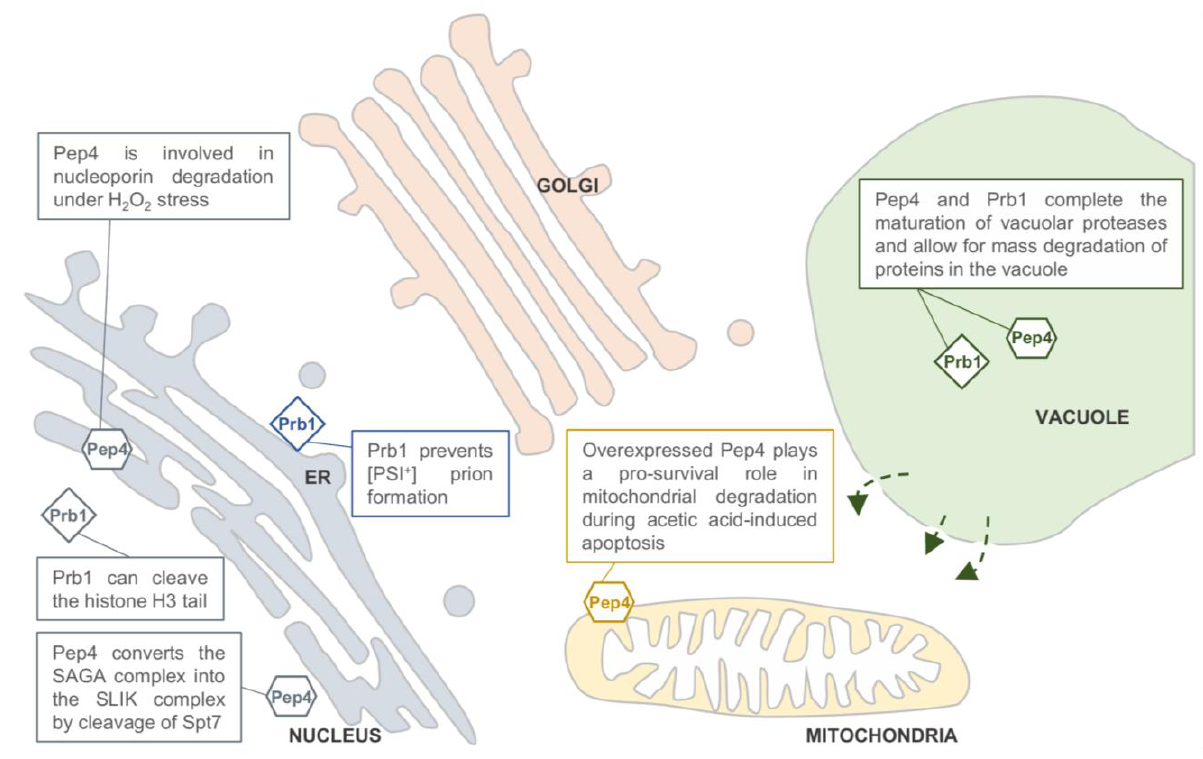
FIGURE 1: Predicted locations of the Saccharomyces cerevisiae proteases Pep4 and Prb1. Both proteases are well known for their role in protein degradation in the vacuole. Pep4 and Prb1 share a prominent role in the proteolytic activation and maturation of most vacuolar proteases, including themselves. Under stress conditions, the permeability of the vacuolar membrane has been reported to increase. This might enable the proteases to escape the vacuole and locate to other sites in the cell (indicated by arrows). It has been reported that Pep4 is associated with mitochondrial degradation under acetic acid-induced apoptosis. Furthermore, it has been described that nucleo- porins are degraded by Pep4 in H 2 O 2 -induced cell death, suggesting a nucleus-associated localization. This idea is strengthened by the importance of Pep4 in the generation of the SAGA-like (SLIK) complex by cleavage of the Spt7 component of the SAGA complex. It was found that the conserved process of H3 clipping, altering gene expression, was performed by the Prb1 protease in S. cerevisiae , also sug- gesting a nuclear localization for Prb1. Furthermore, Prb1 was shown to inhibit [PSI + ] prion formation. Okamoto et al. [6] hypothesize that prevention of prion formation by cleavage of the Sup35 protein takes place on actively translating ribosomes. It should be noted that the non-vacuolar localizations of Pep4 and Prb1 were never confirmed in vivo by conclusive experimental